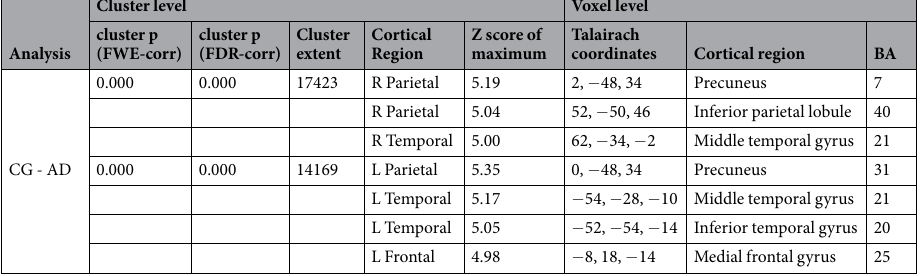
Table 2. Statistical parametric mapping comparisons between 18 F-FDG uptake in CG and AD. In the ‘cluster level’ section on left, the number of voxels, the corrected P value of significance and the cortical region where the voxel is found, are all reported for each significant cluster. In the ‘voxel level’ section, all of the coordinates of the correlation sites (with the Z-score of the maximum correlation point), the corresponding cortical region and BA are reported for each significant cluster. L, left; R, right; BA, Brodmann’s area. In the case that the maximum correlation is achieved outside the grey matter, the nearest grey matter (within a range of 5 mm) is indicated with the corresponding